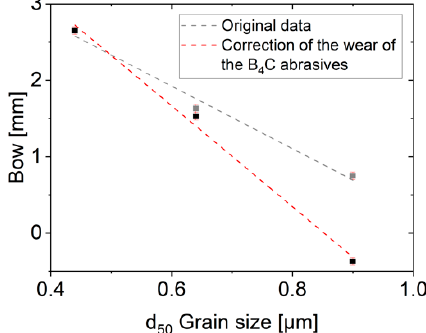
Figure 7. Influence of the alumina ceramic grain size on the size of the wire bow; regression of original data: − 4.09 ( ± 0.48) × + 4.38 ( ± 0.33); COD (r 2 ): 0.98; regression of the corrected data = − 6.60 ( ± 0.48) × + 5.63 ( ± 0.33); COD (r 2 ): 0.99).